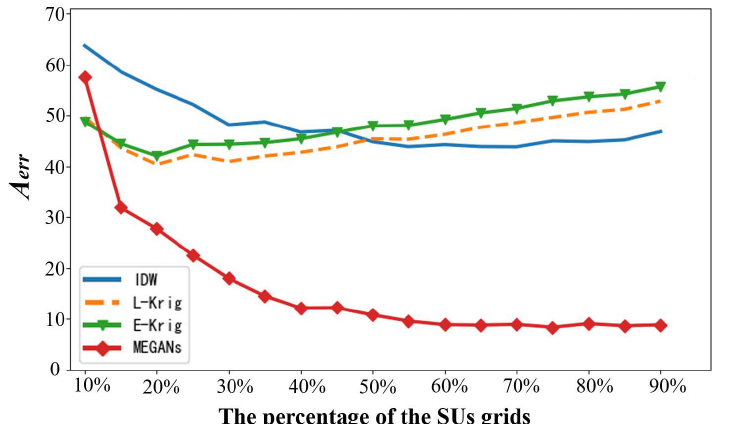
Figure 13. The average image reconstruction errors over different numbers of receiving SUs. The percentages of the SUs’ grids accounting for the whole target region are shown on the horizontal axis. The average image reconstruction errors A err are shown on the vertical